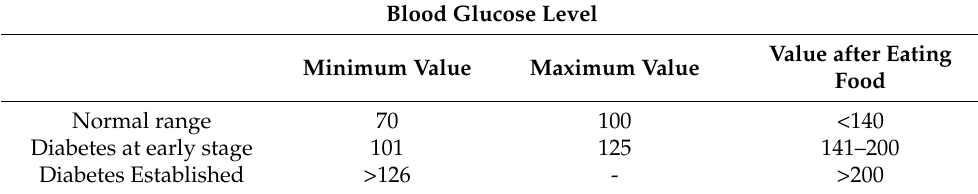
Value after Eating Food